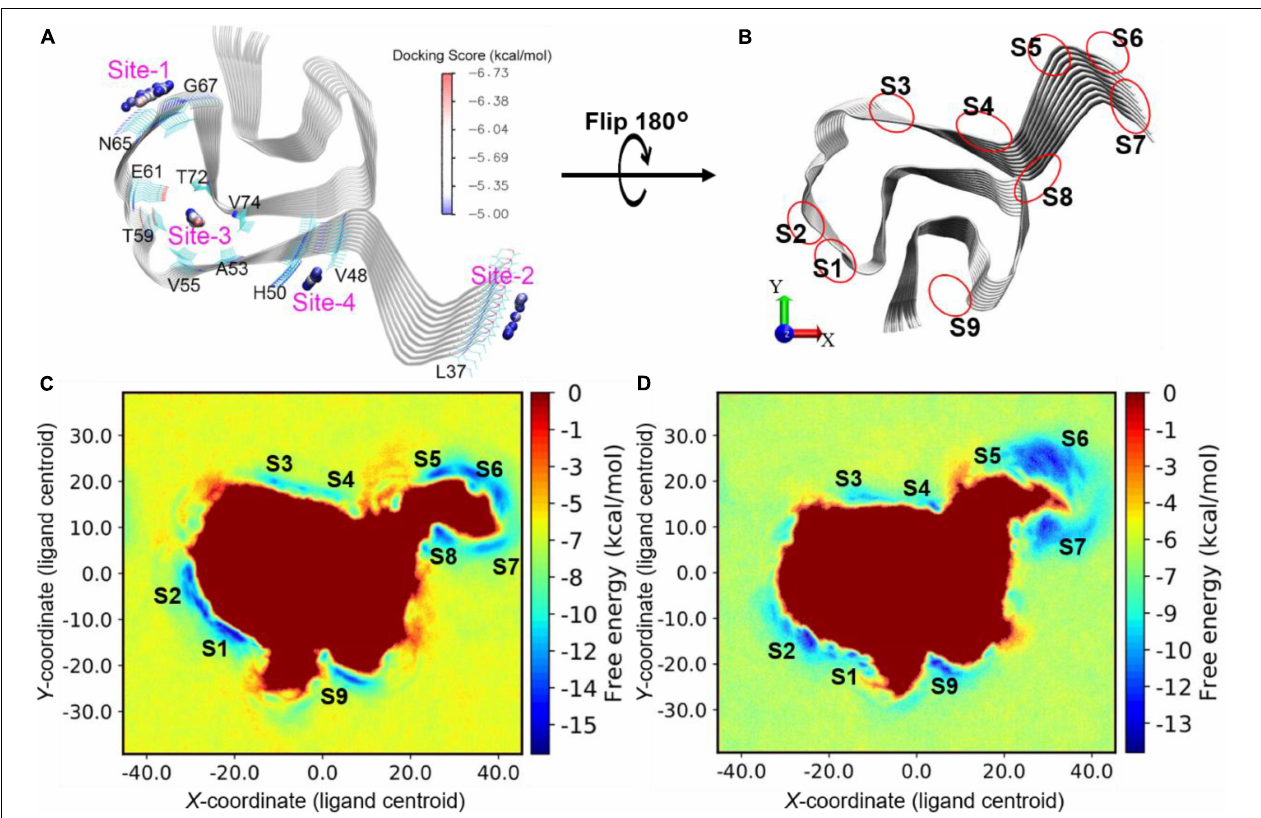
FIGURE 8 | (A) Blind docking identified sites (labeled from “Site-1” - “Site-4”) with favorable docking scores ( < –5 kcal/mol) for DABTAs and DCVJ. The geometrical centers of the docked ligands are depicted as small spheres and colored by the range of docking scores. (B) Illustration of sites identified by metadynamics simulations. (C) Free energy profile for d 4 binding onto the surface sites of α -syn. (D) Free energy profile for d 8 binding onto the surface sites of α -syn. The free energy local minima are named with “S” combined with identity